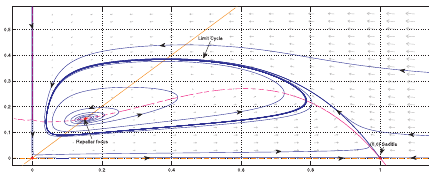
Figure 6. For A = 0 . 1 , B = 0 . 02 , S = 0 . 15 and S = 0 . 7, the unique positive equilibrium is a repeller focus surrounded by a stable limit cycle and (1 , 0) is a hyperbolic